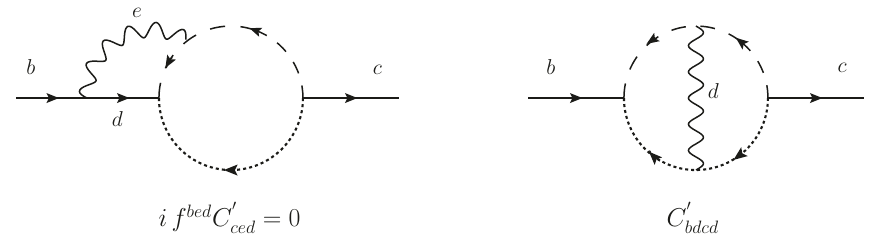
Figure 6 . Two-loop diagrams and their color